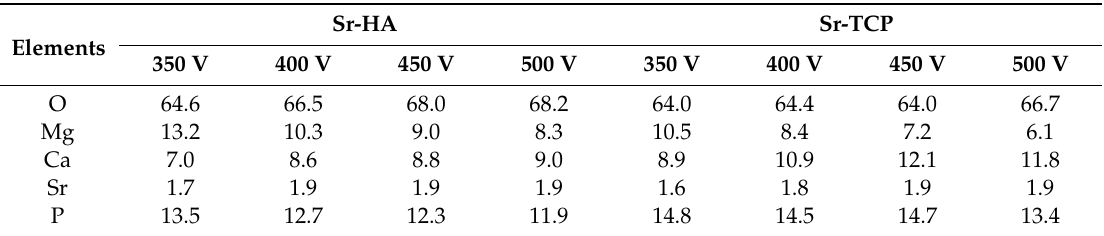
Figure 7. SEM image of the Sr-HA ( a ) and Sr-TCP ( b ) coatings deposited at 400 V; element distribution maps. Table 1. The elemental composition of the Sr-HA and Sr-TCP coatings on Mg0.8Ca determined by the EDX method in the region, (at.%).